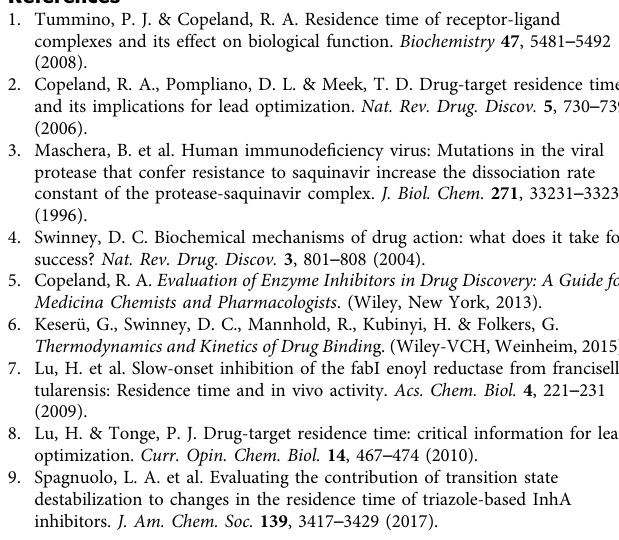
Fig. 8a. Two different methods, (1) quasi-harmonic approximation, QH, and (2) correlation-corrected multibody local approximations, CC-MLA 54 , were used for computing the difference in entropy between the loop-in and the helical conformations of the protein, T Δ S P l-h . Computation of the protein